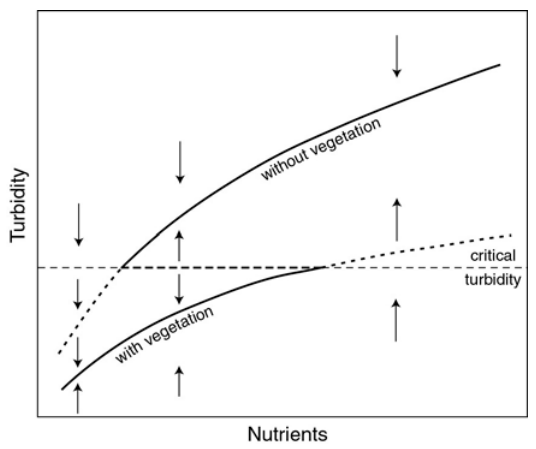
FIGURE 3. Alternative equilibrium turbidities caused by disappearance of submerged vegetation when a critical turbidity is exceeded (see text for explanation). The arrows indicate the direction of change when the system is not in one of the two alternative stable